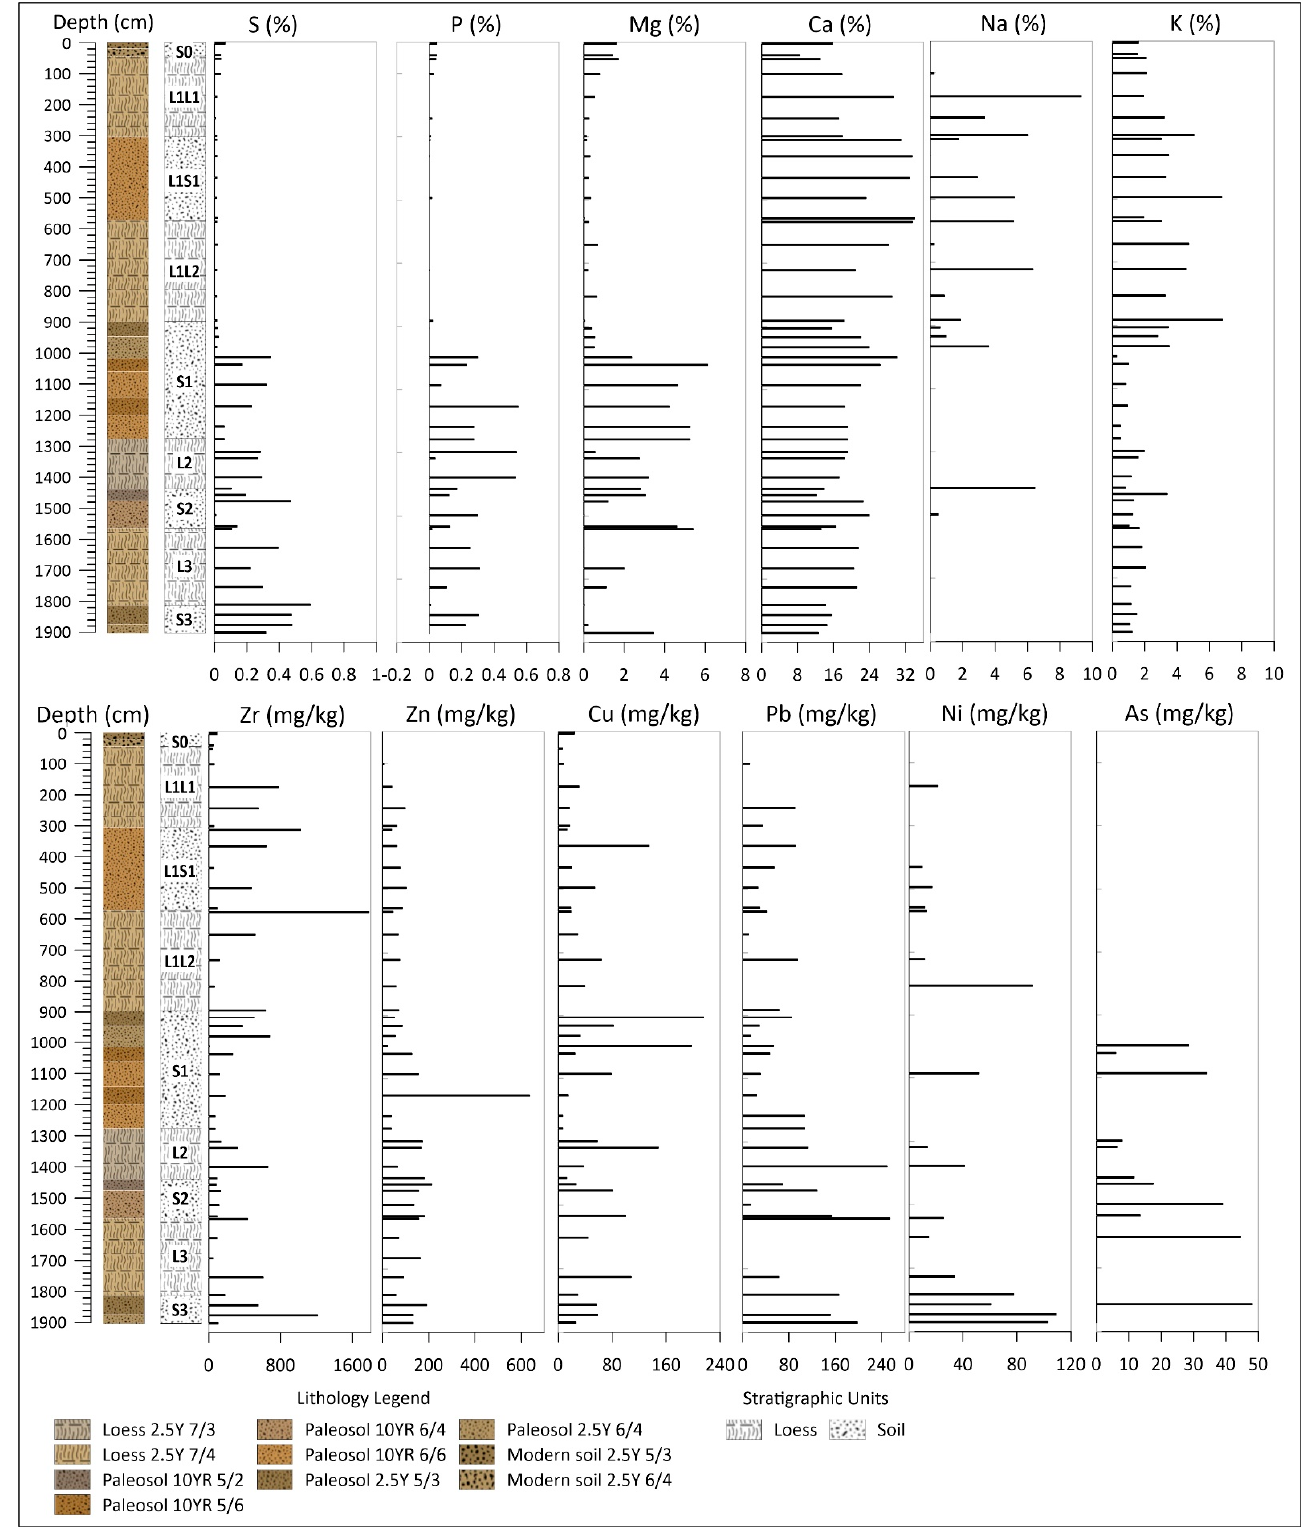
Figure 3. Highlighted geochemical results from XRF (major elements above, trace elements below).